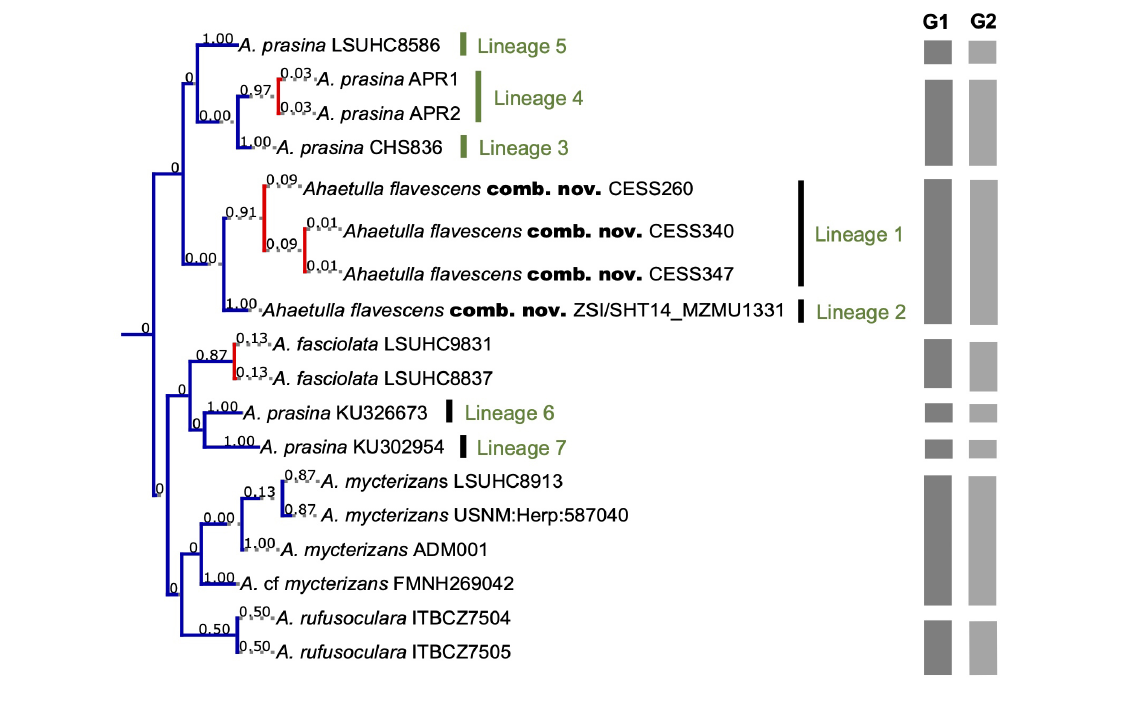
Fig. 2. The bPTP output trees generated from three mitochondrial loci ML trees. Blue coloured branches and black bars indicate monophyly of that lineage, where validity of lineages is further ascertained with genetic divergence (genetic p-distance) and geographic isolation. The grey bars indicate the genetic distance (G1) and geographic isolation (G2) among lineages. The values on clades indicate the posterior probability. The A. prasina complex (Lineage 1 and Lineage 2) from northeast India shows a very low genetic divergence with continuous geographic